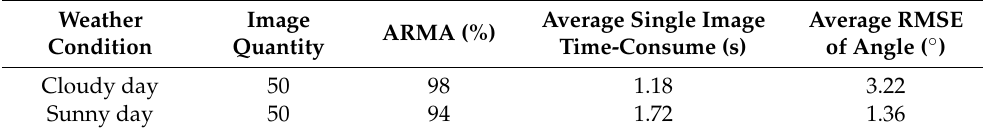
Table 7. Recognition and fitting results of different lighting conditions.